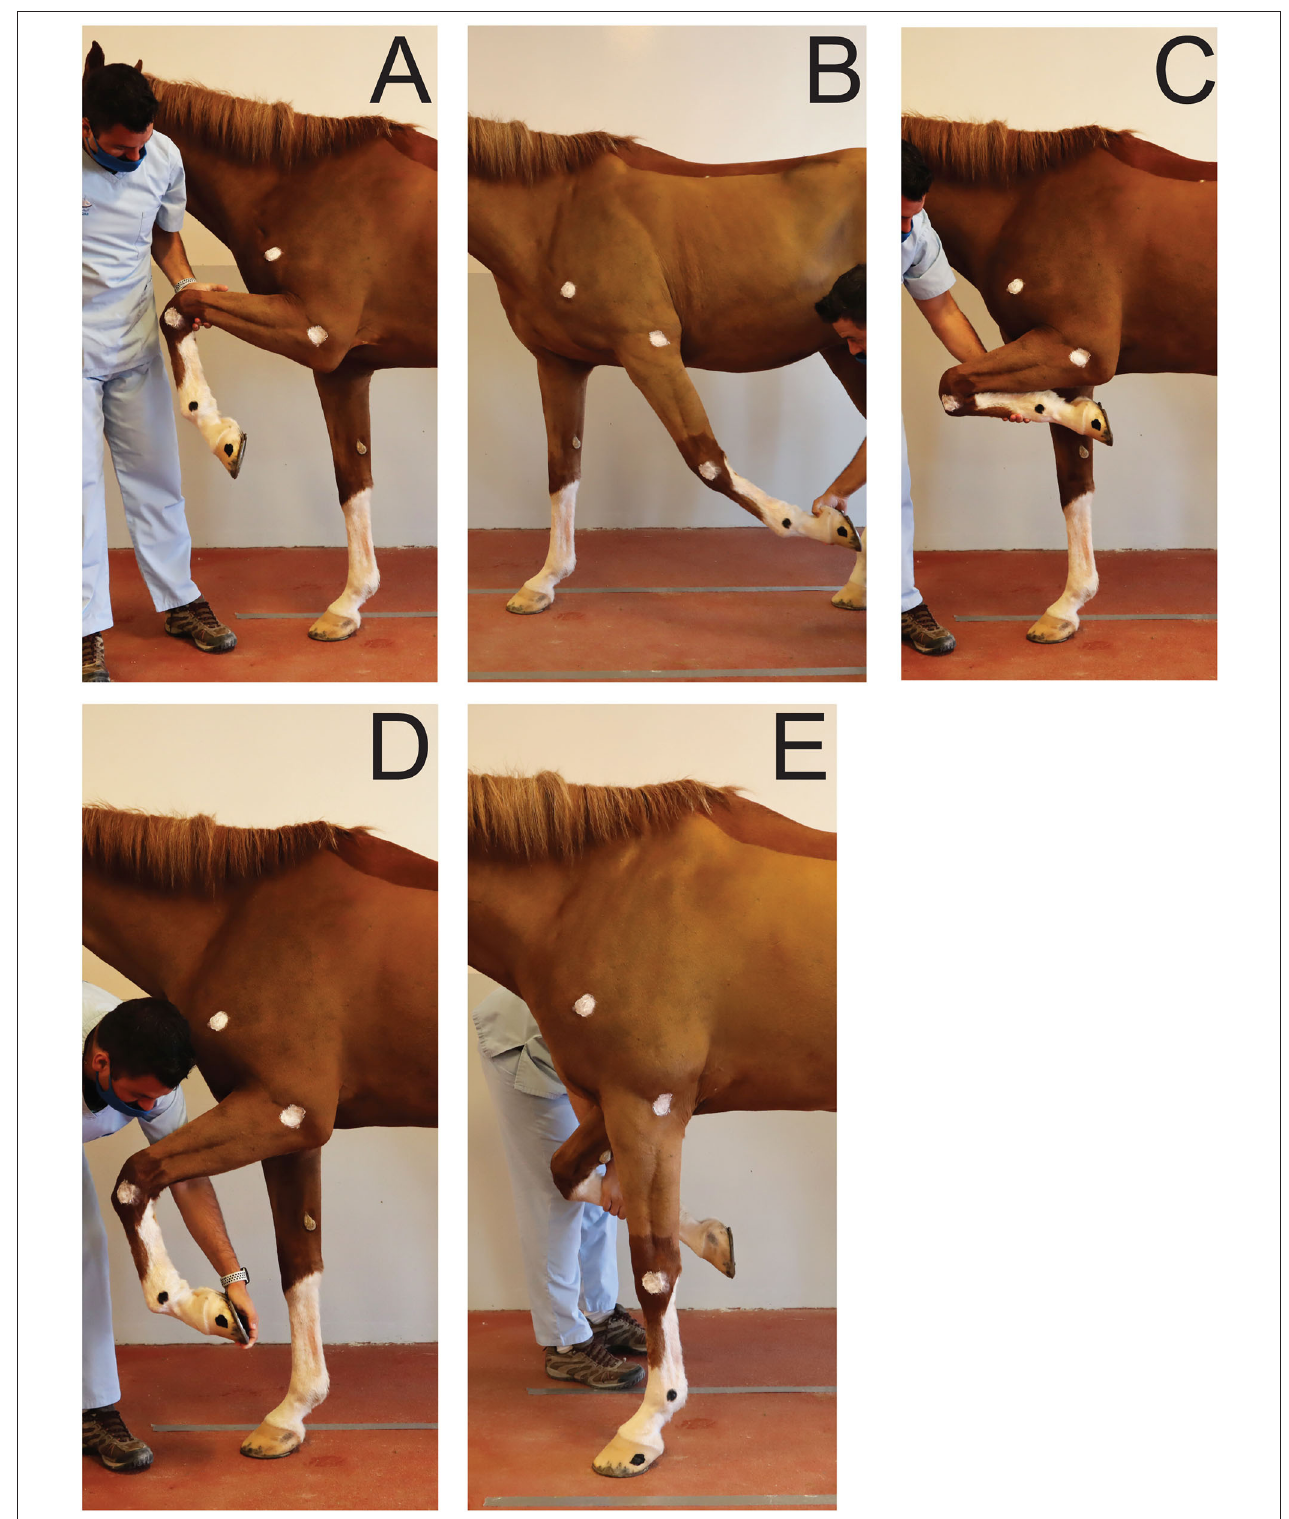
FIGURE 2 | Positions obtained for maximal flexion and extension of the joints of interest during passive mobilization. (A) Maximal elbow flexion; (B) Maximal elbow extension; (C) Maximal carpus flexion; (D) Maximal fetlock flexion; (E) Maximal carpus and fetlock extension.